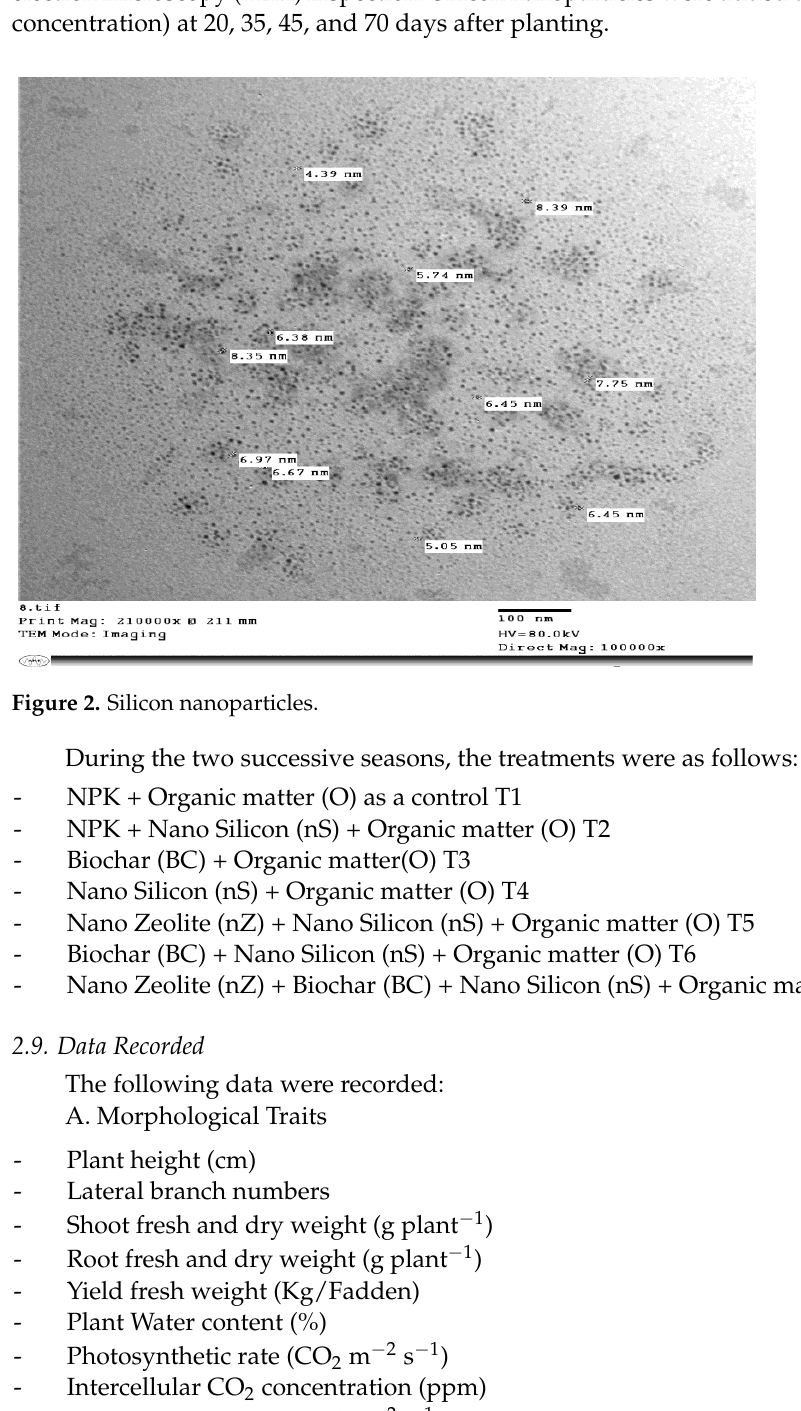
Figure 1. Zeolite nanoparticles.